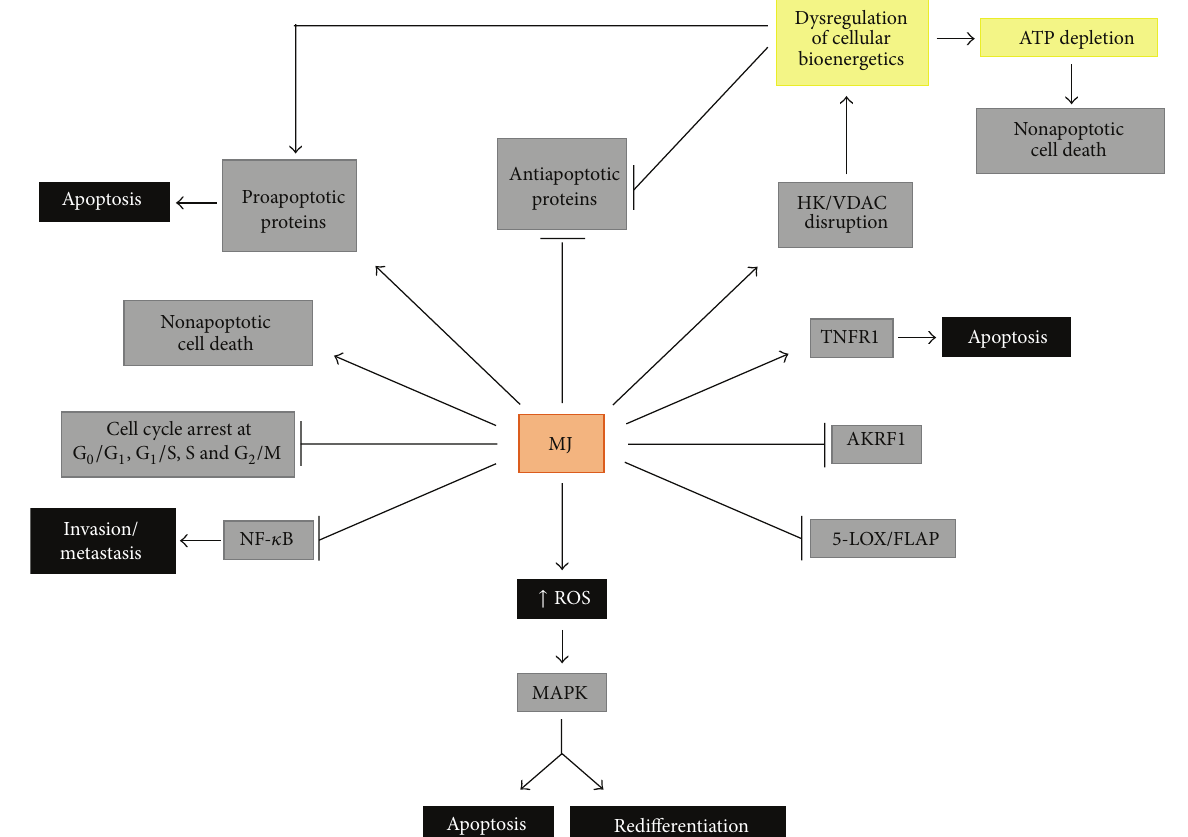
Figure 4: Methyl jasmonate mediated activities in cancer cells. MJ and other jasmonates (JAs) (1) arrest cell cycle, inhibiting cell growth and proliferation; (2) cause cell death by triggering the intrinsic and extrinsic proapoptotic pathways and induce also p53-independent apoptosis and nonapoptotic cell death or necrosis; (3) detach hexokinase (HK) from the voltage-dependent anion channel isoform 1 (VDAC1), dissociating glycolytic and mitochondrial functions, decreasing the mitochondrial membrane potential ( Δ𝜓 𝑚 ), favoring cytochrome 𝑐 release, causing ATP depletion, and activating proapoptotic and inactivating antiapoptotic proteins; (4) induce reactive oxygen species (ROS), triggering and/or mediating different cellular responses; (5) stimulate MAPK-stress signaling pathways and induce redifferentiation in leukemia cells; (6) inhibit overexpressed cancer cell enzymes such as aldo-keto reductase 1 (AKR1) and 5-lipoxygenase (5-LOX).